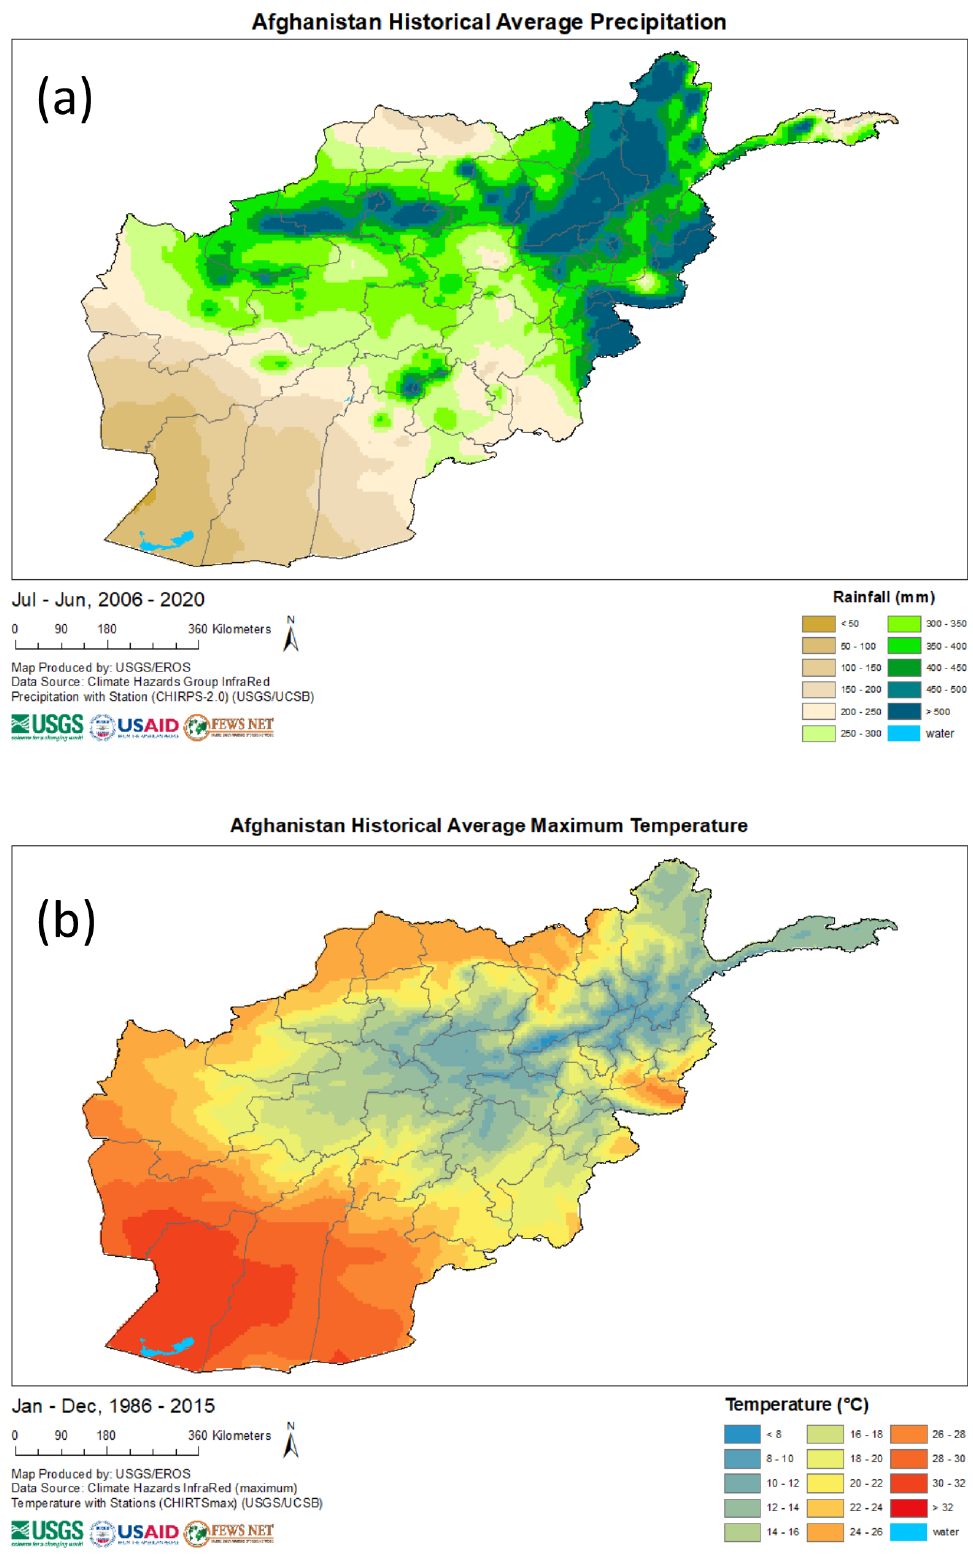
Figure 1. (a) Average annual precipitation in Afghanistan from 1991–2020, with overlaid province boundaries. (b) Average maximum monthly temperature from 1986–2015, overlaid with province boundaries. Map source USGS Knowledge Base